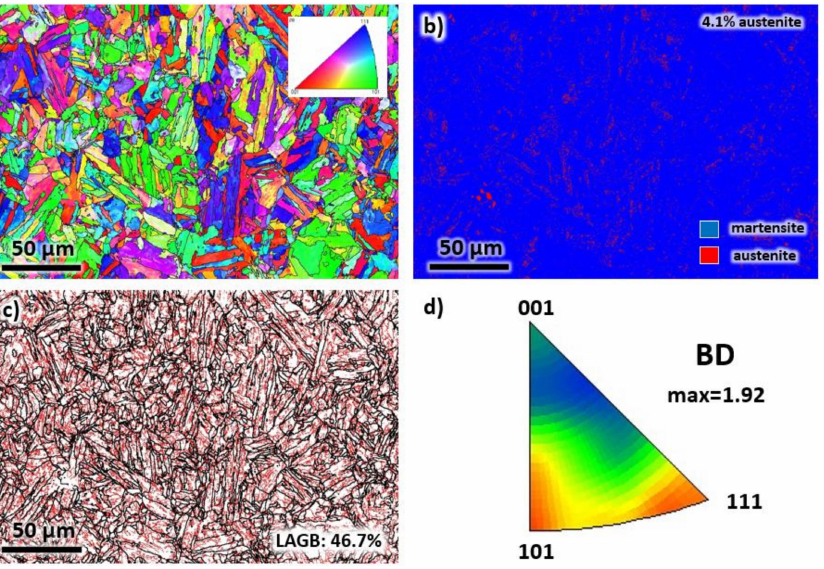
Figure 9. The ( a ) EBSD map, ( b ) phase map, ( c ) grain boundary map, and ( d ) IPF representation of each grain of the heat-printed sample taken from the transverse